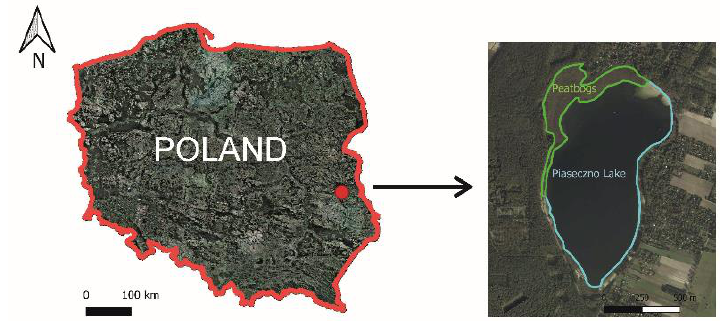
Figure 1. Location of the study area.